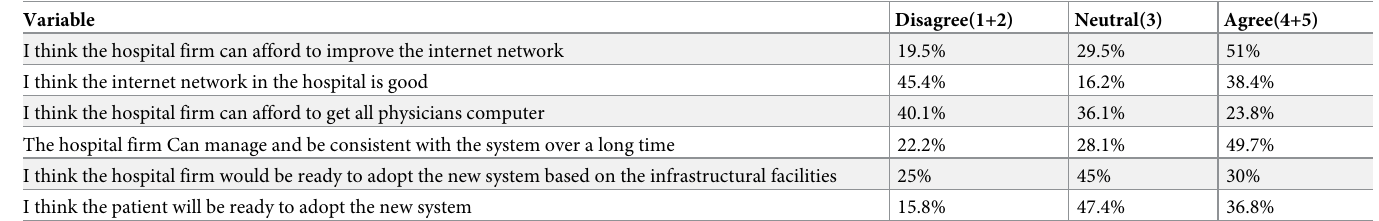
Table 4. Perceived readiness of organization to implement e-prescription (N = 302).